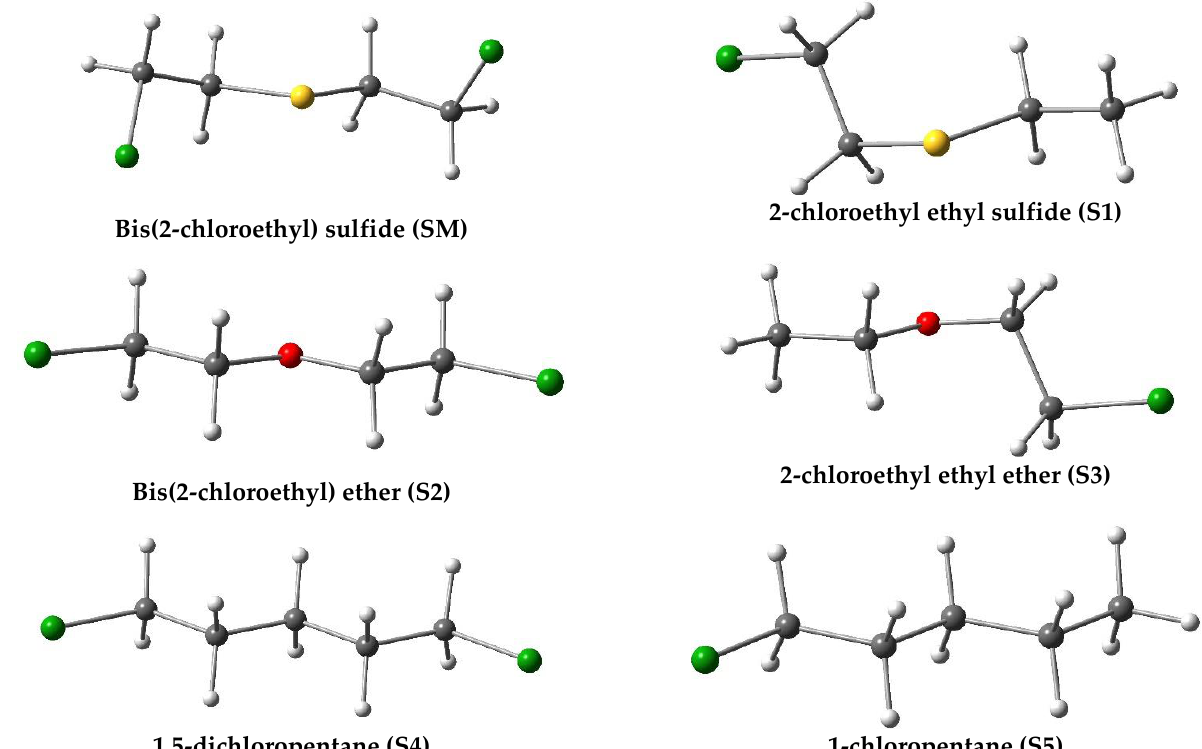
Figure 1. Optimized molecular structures of the guests: SM, S1, S2, S3, S4, and S5. Atom colors: chlorine (green); oxygen (red); carbon (grey); sulfur (yellow) and hydrogen (white).